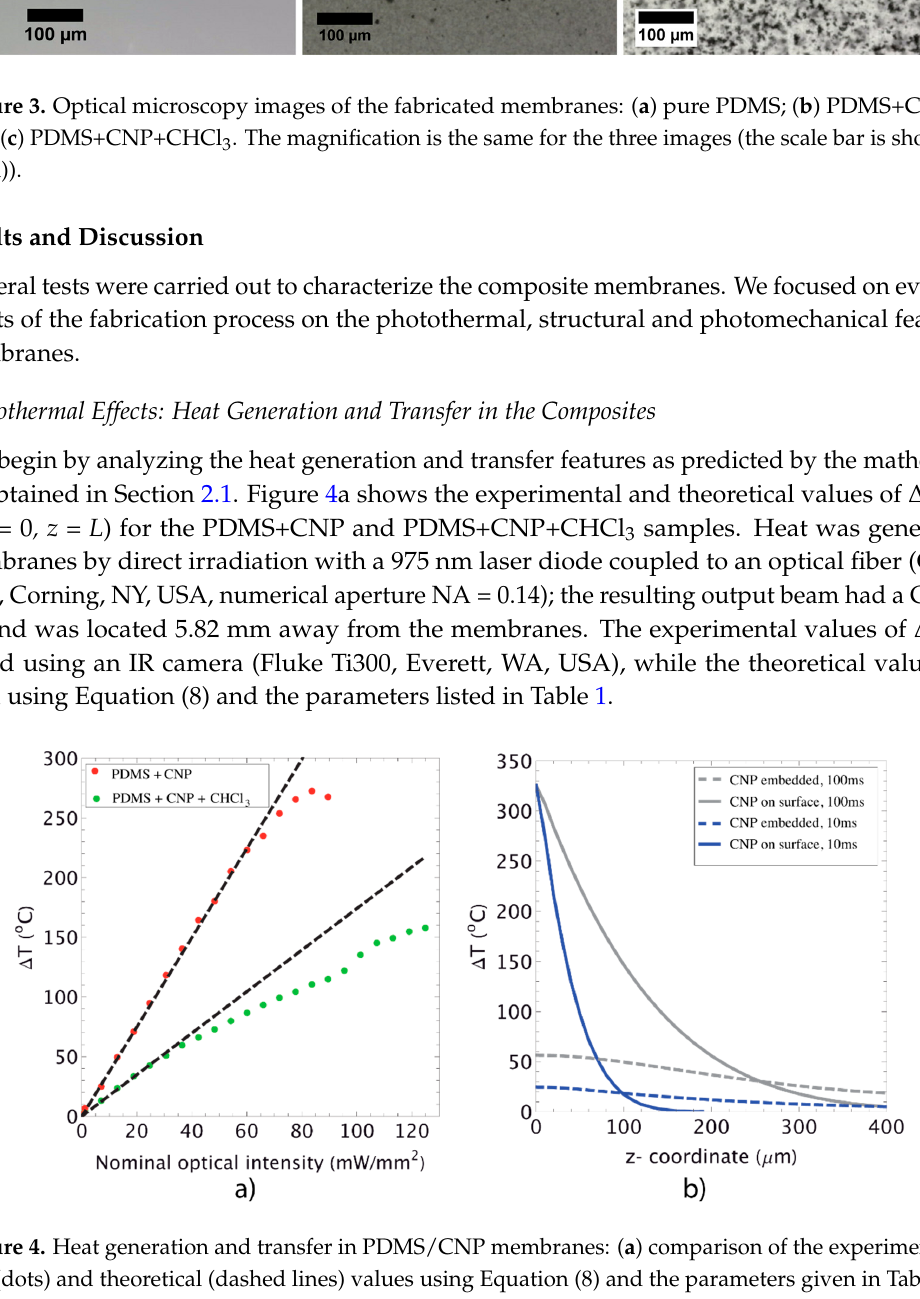
Figure 3. Optical microscopy images of the fabricated membranes: ( a ) pure PDMS; ( b ) PDMS+CNP; and ( c ) PDMS+CNP+CHCl 3 . The magnification is the same for the three images (the scale bar is shown in ( a )).